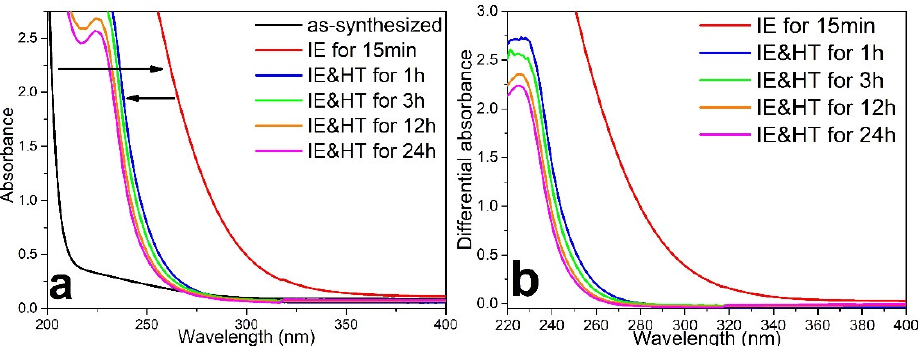
Figure 4. ( a ) Absorbance spectra of as-synthesized and Na + –Ag + ion-exchanged PTR-M glass sam- ples after heat treatment at 500 °С for different durations measured after removing the SNIF. ( b ) The differential absorbance spectra obtained by subtracting the spectrum of the as-synthesized sample from the others.